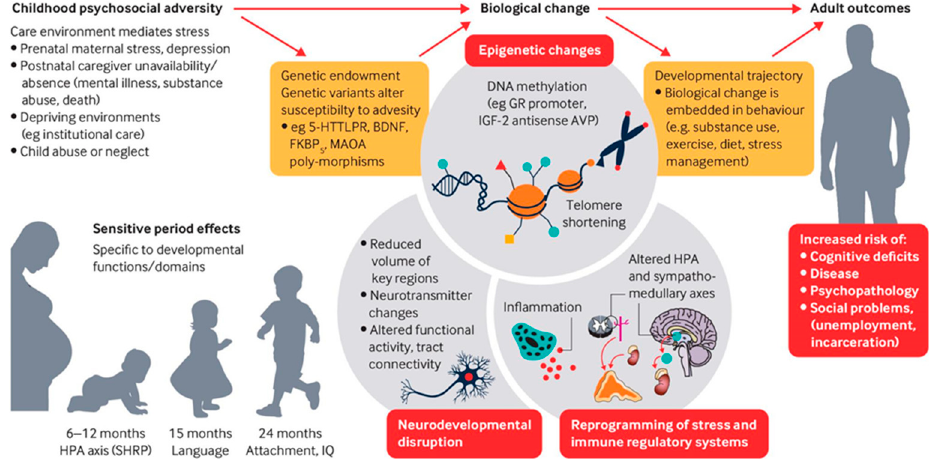
Figure 1. Childhood exposure to adverse childhood events (ACEs) and pathways to adult outcomes (from Nelson, et al. Adversity in childhood is linked to mental and physical health through life. BMJ 2020 , 371 , m3048. [43]. Shared under a creative commons open-access license.).